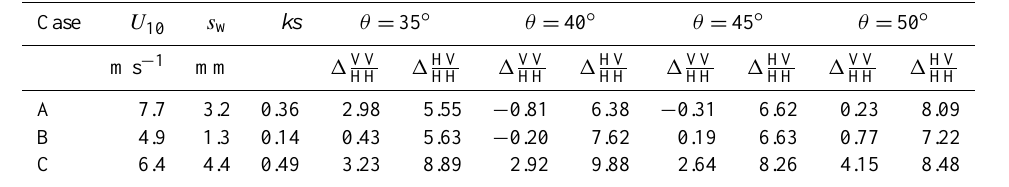
Table 3. Crosswind to upwind ratios, (cid:49) VV / HH and (cid:49) HV / HH (in dB), for three cases at incidence angles ( θ ) spanning the 35 to 50 ◦ range at 5 ◦ intervals. Coincident wind speed U 10 , surface rms height s w and ks values for each case are given.